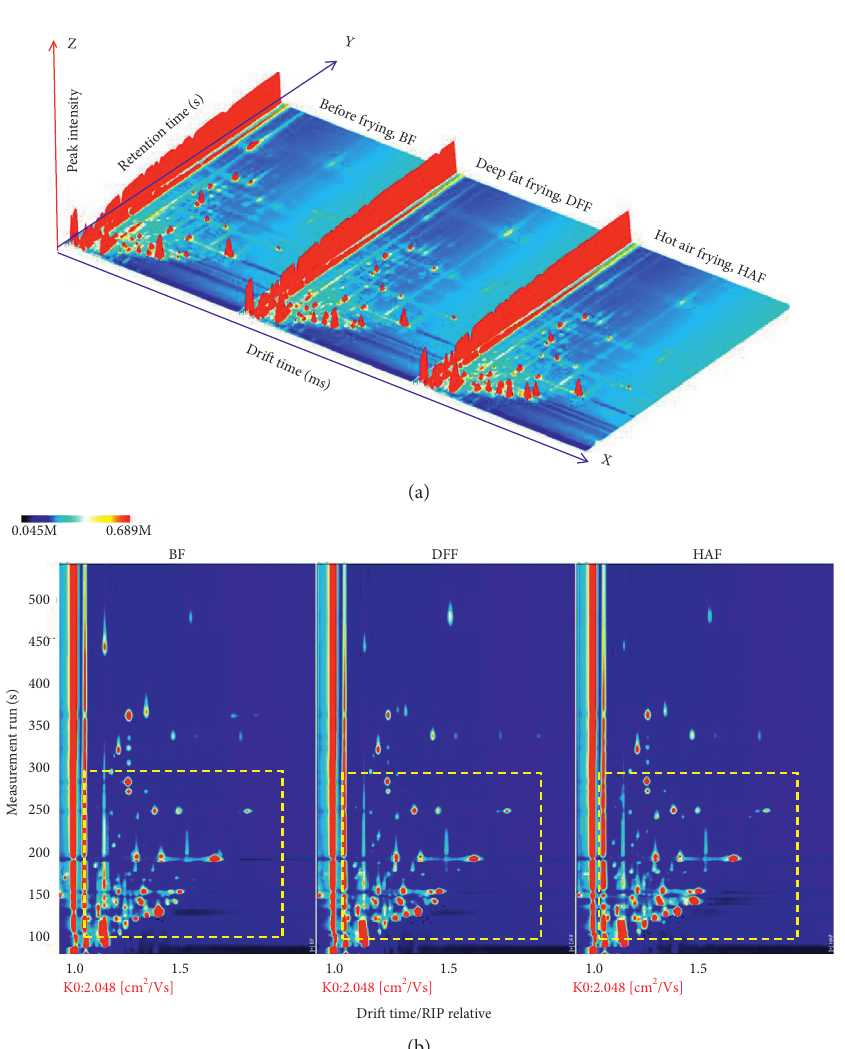
Figure 2: GC-IMS spectra of giant salamander meatball before and after frying. (a) Three-dimensional view; (b) two-dimensional